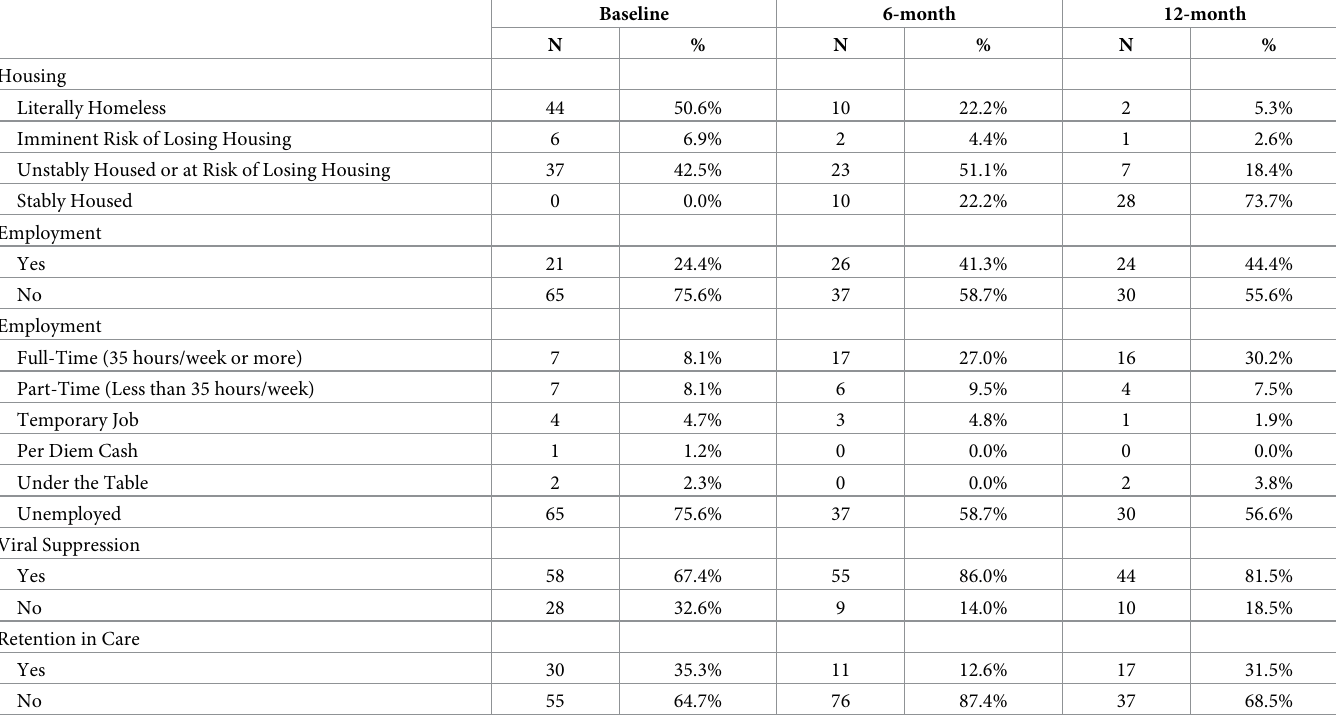
Table 2. Baseline, 6-month, and 12-month